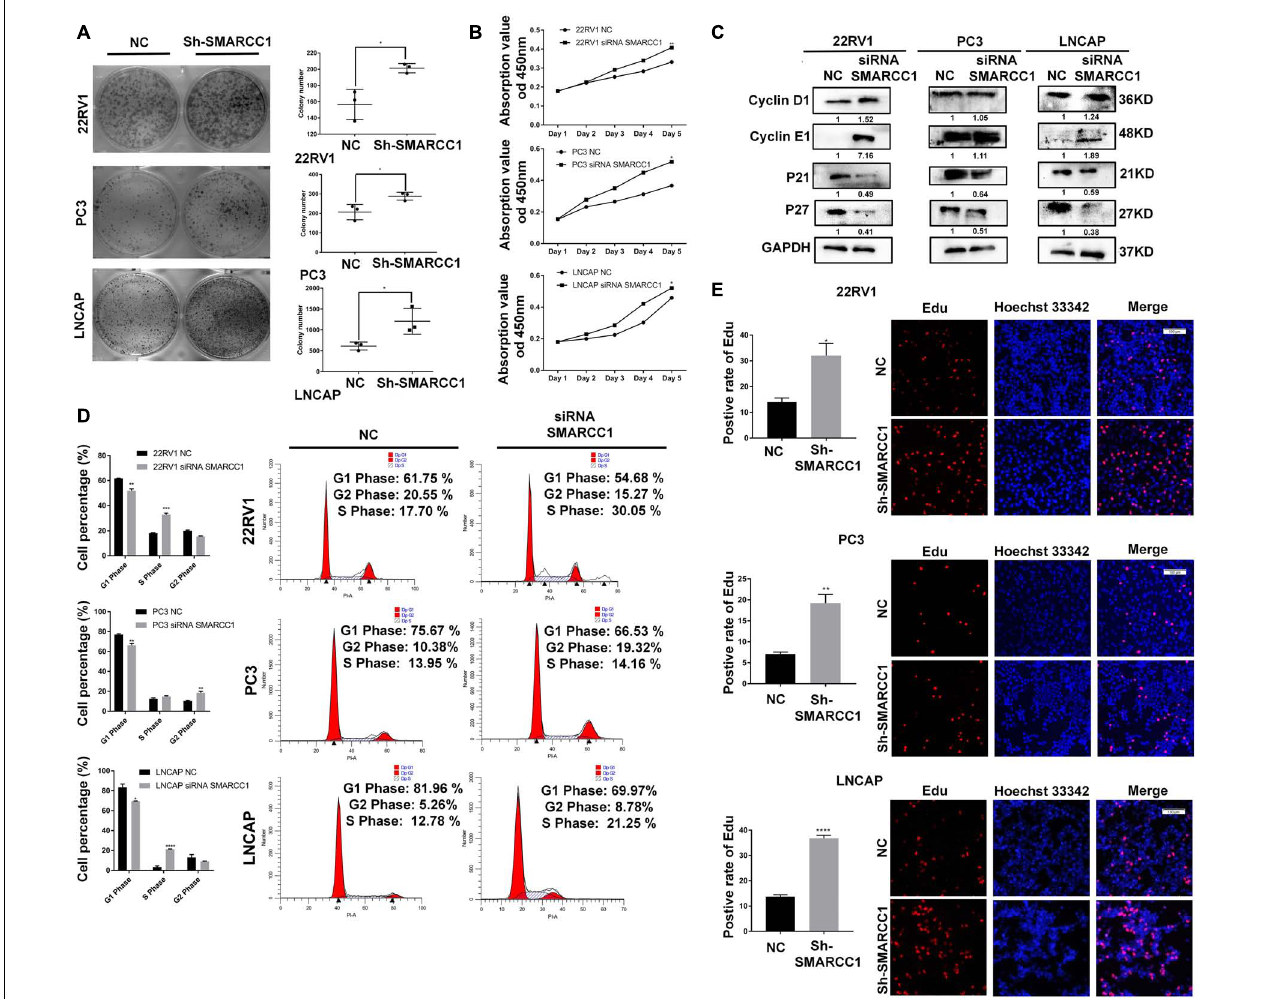
FIGURE 2 | SMARCC1 knockdown increased PCa cell viability and proliferation. (A) Number of colonies formed by control and SMARCC1 knockdown PCa cells. (B) Percentage of viable PCa cells treated as indicated. (C) CKI and cyclin mRNA and protein levels in the indicated groups. Relative mRNA expression levels are shown in the bar graph, and gray density values of proteins are indicated under the corresponding bands. (D) Bar graph showing the distribution of PCa cell lines in the different cell cycle stages. (E) Representative images (right panel, scale bar: 100 µ m) of EDU-stained cells and bar graph showing the percentage of EDU-positive cells in the S phase. All data are presented as mean ± SEM of at least three independent experiments. * p < 0.05; ** p < 0.01; *** p < 0.001; **** p <